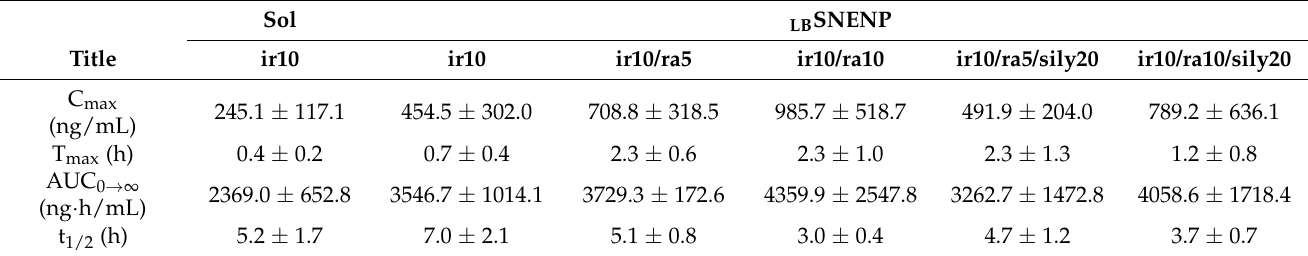
Table 9. PK parameter estimation of SN38G after oral administration with Sol ir10 , LB SNENP ir10 ,